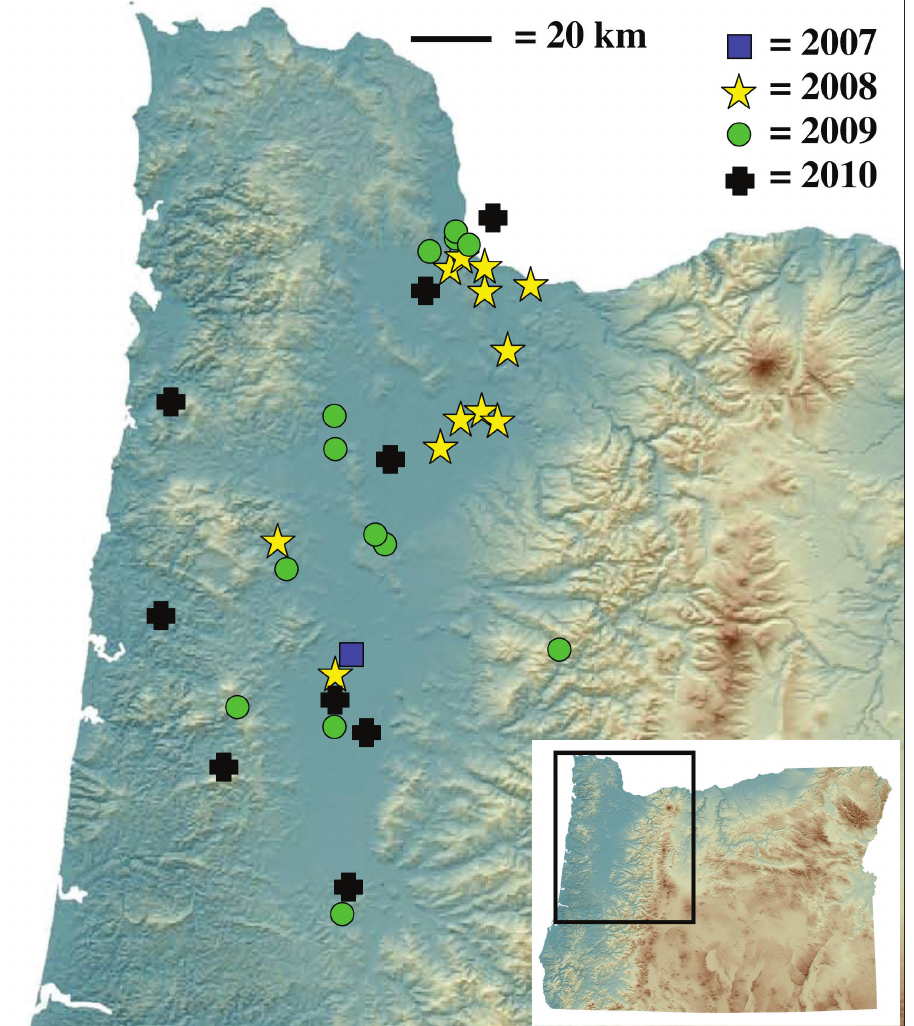
Figure 4. Known localities of Nebria brevicollis in North America through 2010 and first year of detec- tion per